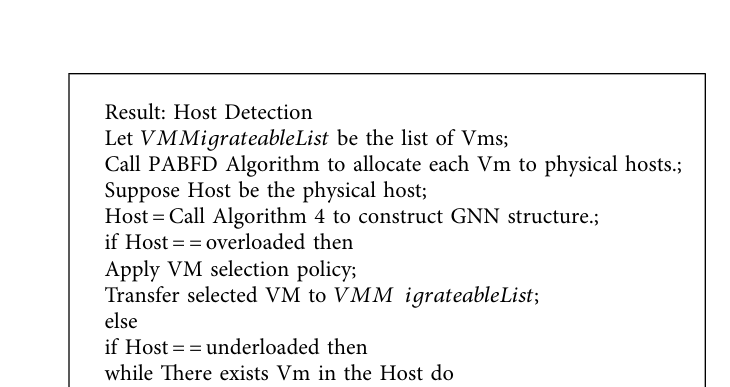
Figure 2: Proposed